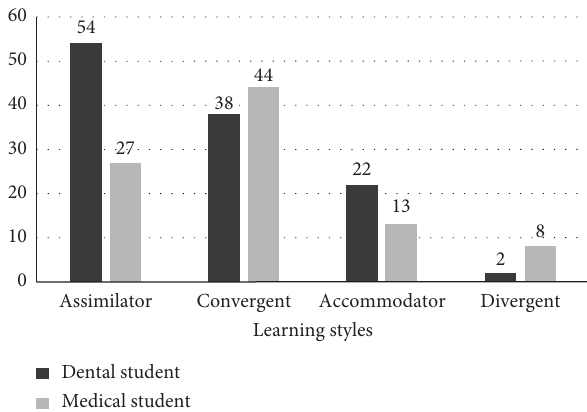
Figure 1: The frequency of learning styles of the study participants by the field of